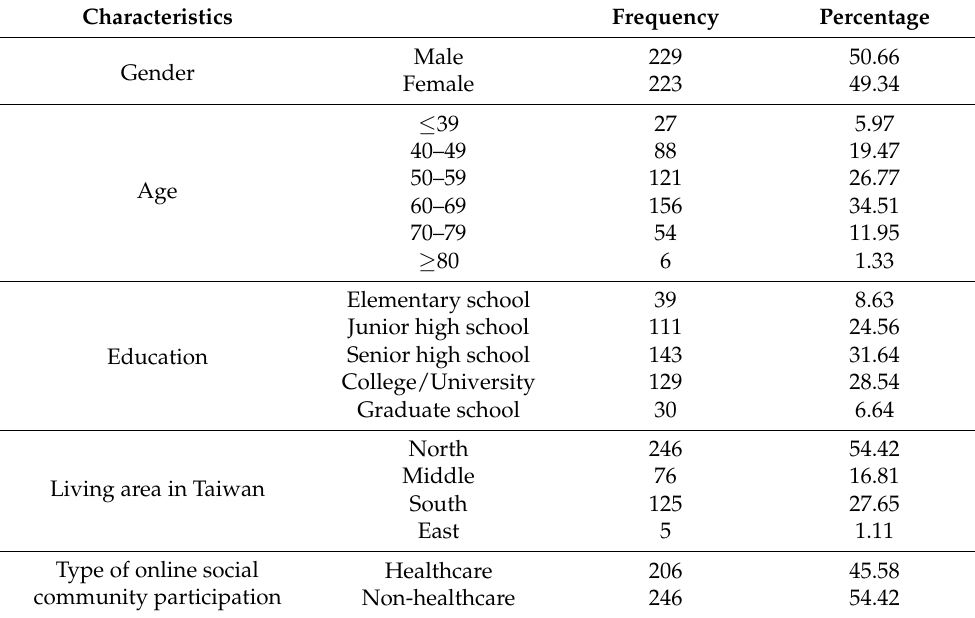
Table 1. Descriptive